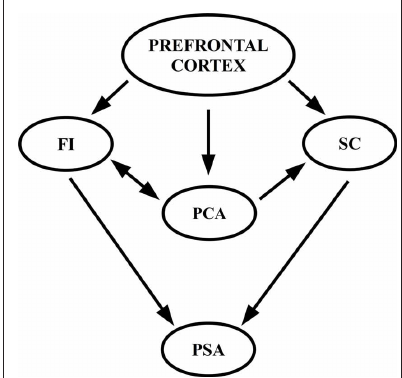
FIGURE 1 | Tentative model of a framework for the relationship between FI, PCA, SC, and PSA. Prefrontal cortex, FI, and SC (which includes PCA) predict